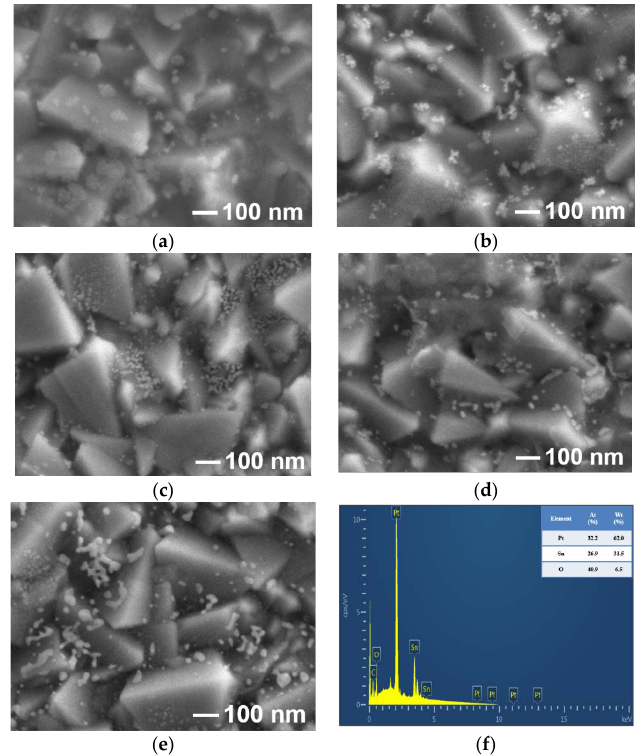
Figure 3. Scanning electron microscope (SEM) images of samples processed by APPJ for various durations: ( a ) 5 s, ( b ) 15 s, ( c ) 30 s, ( d ) 60 s, and ( e ) 120 s. ( f ) Energy-dispersive spectroscopy (EDS) spectrum of nanoparticles converted from H 2 PtCl 6 /SnCl 2 precursors on FTO glass substrates using 120 s APPJ